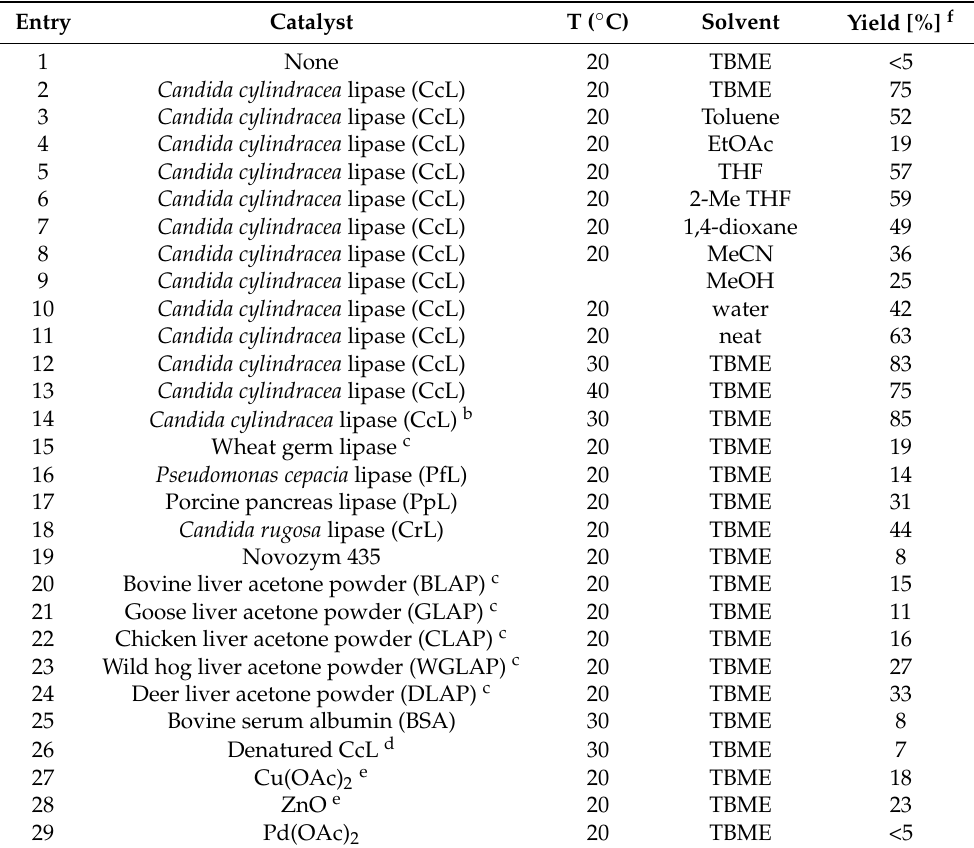
Table 1. Model Knoevenagel–phospha–Michael addition to malononitrile catalyzed by enzymes. [a] Optimization